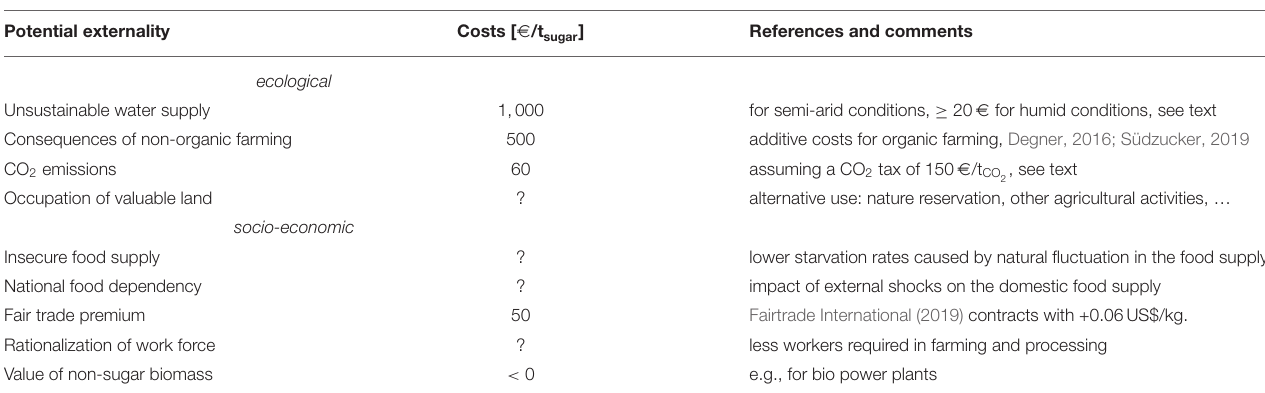
TABLE 3 | Externalities of the conventional sugar